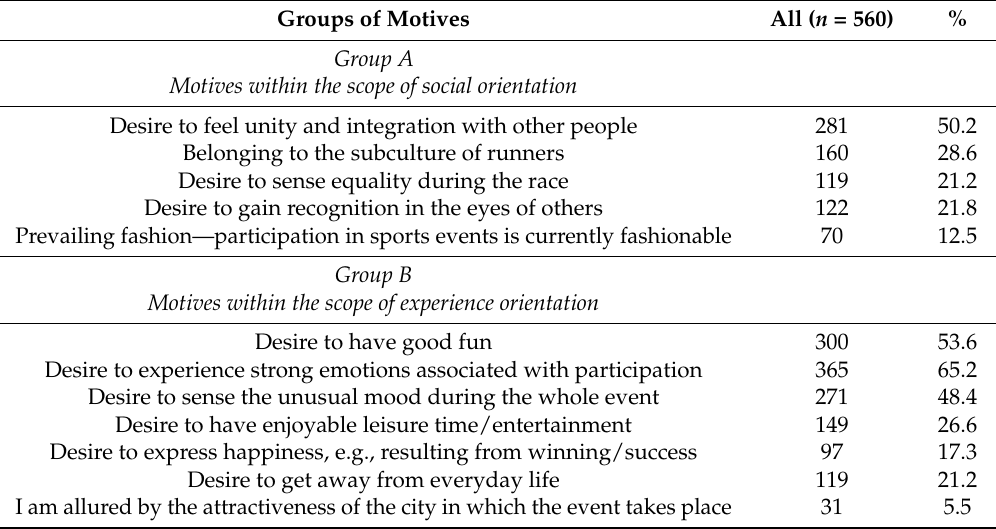
Table 2. Motives within the scope of social and experience orientation ( n =